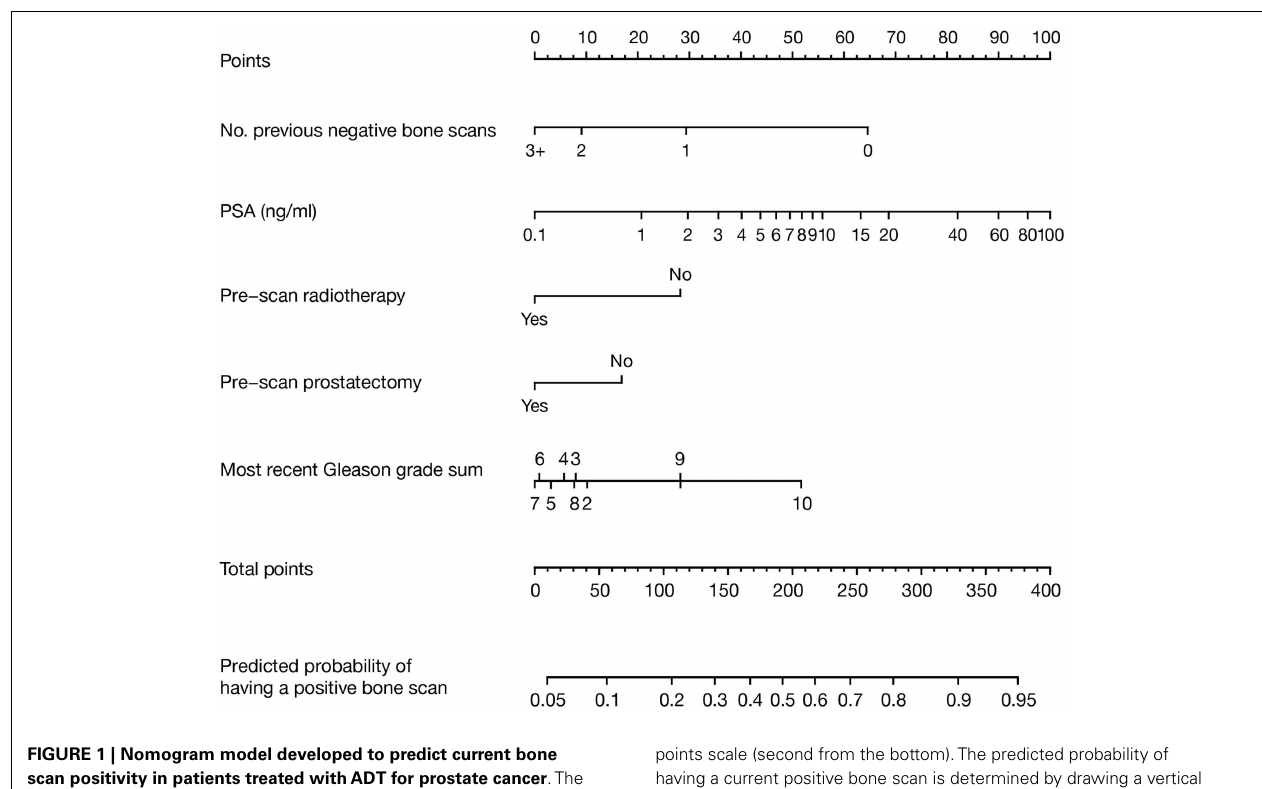
FIGURE 1 | Nomogram model developed to predict current bone scan positivity in patients treated withADT for prostate cancer .The result for each variable has a corresponding points score (top scale).The points score for each variable is determined and summed to calculate the total points for a given patient.This value is located on the total